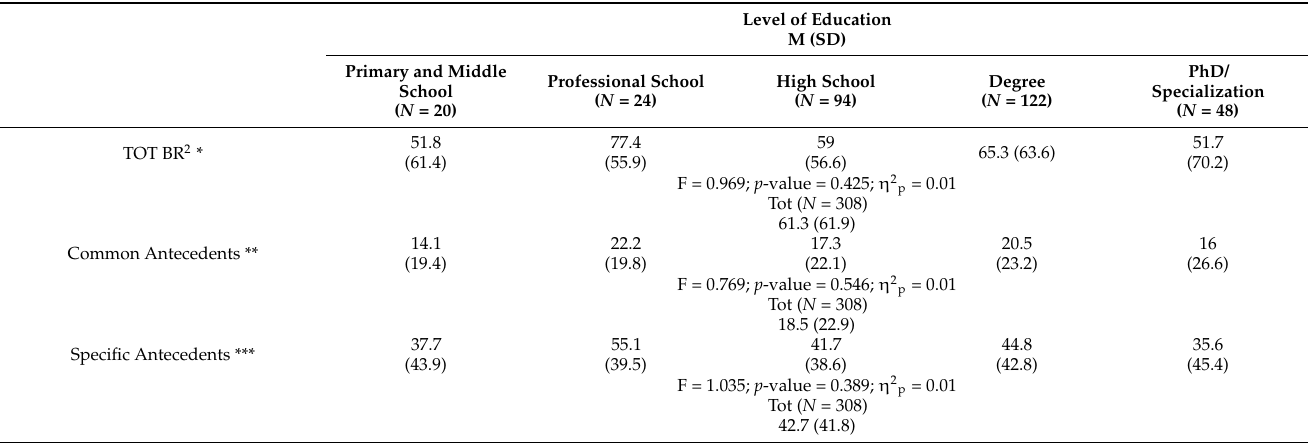
Table 3. Parental distress descriptive data and ANOVA analyses for educational